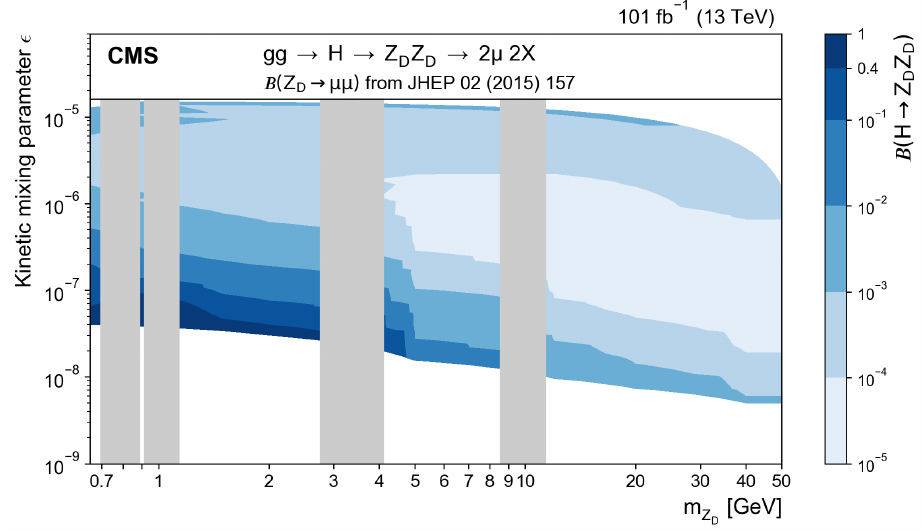
Z ) as contours in D D ) and the signal kinetic mixing parameter Z D → mm ) from the model of ref. [6]. D